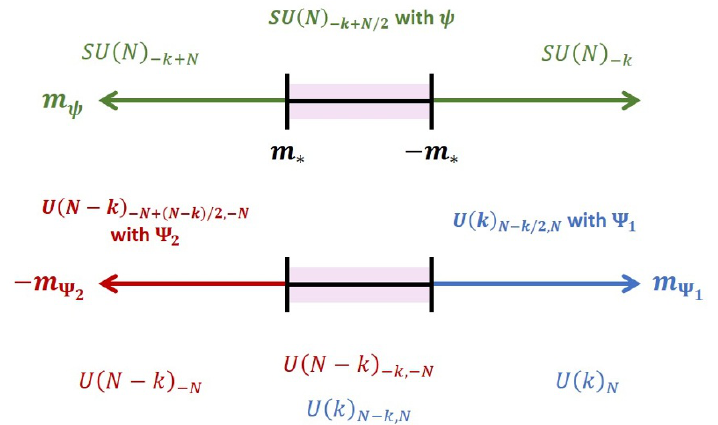
Figure 4 . Phase diagram of the 3d bosonization duality with real adjoint matter [6]. Distinct the- ories are shown in di(cid:11)erent colors. The region shaded in purple corresponds to the quantum